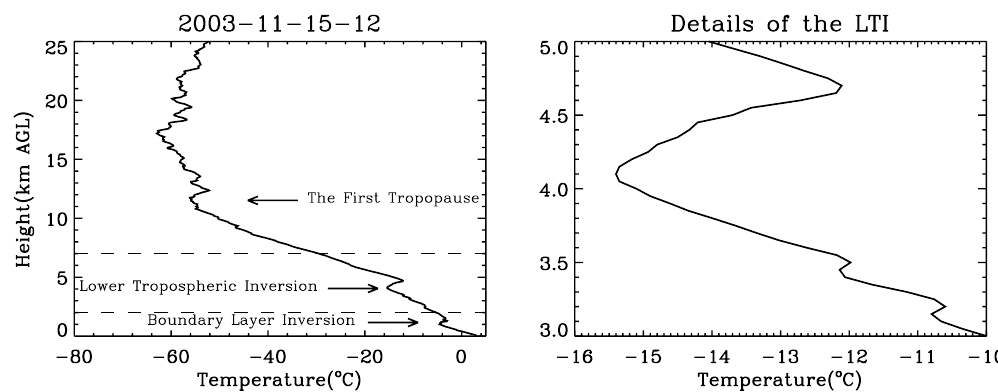
Fig. 2. Temperature-height profile over Brookhaven (40.9 ◦ N, 72.9 ◦ W) at 12:00UT on 15 November 2003.